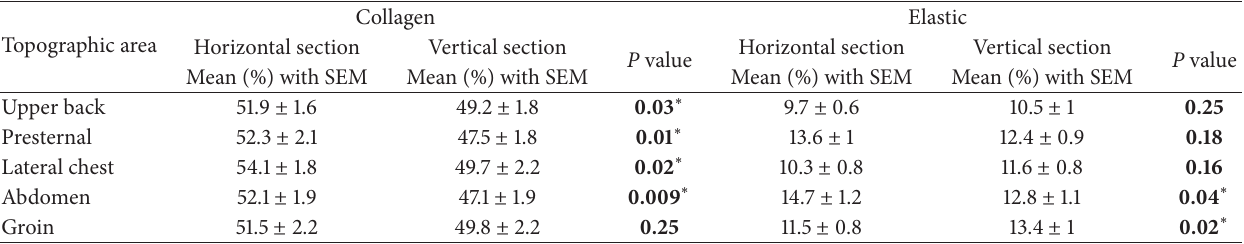
Table 1: Mean quantitative fraction (%) with SEM and the result of paired sample 𝑡 test between 2 directions for collagen and elastic fibre quantity measured by tissue-quant image